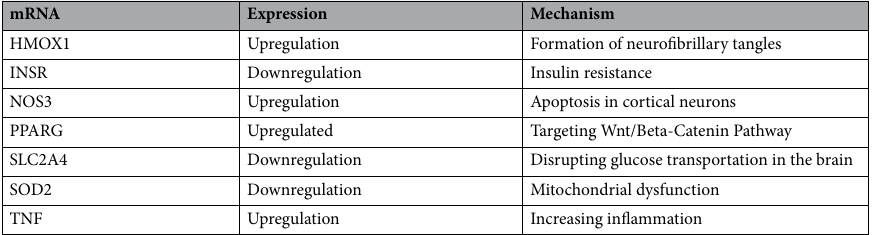
Table 2. mRNAs interpretation. In this table, 7 mRNAs in the cross-talk between DM and AD (achieved from curatedDisgenet database) and their mechanisms in the relationship between the two intended diseases